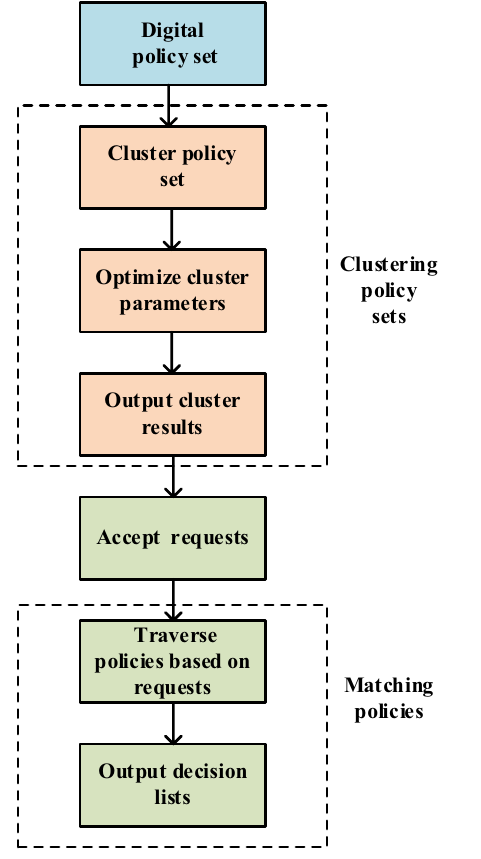
Figure 1. Working process of